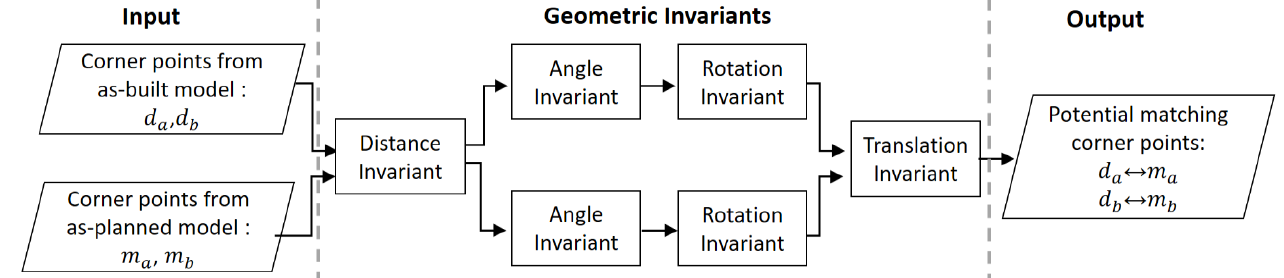
Figure 4. The processing sequence of geometric invariants to identify the potential matching corner points in a cycle.